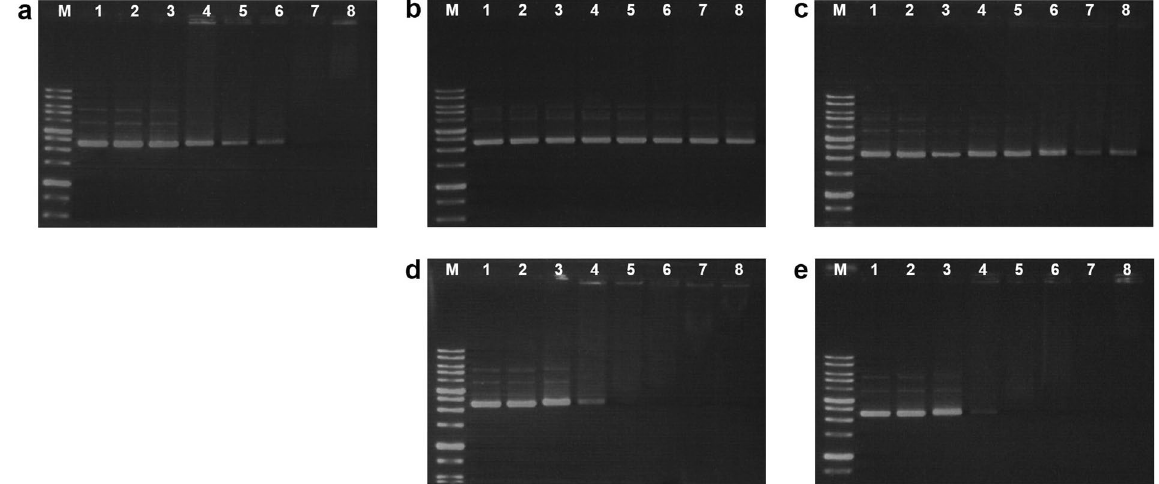
Figure 7. DNA binding assay. Peptide-DNA binding was assayed by evaluating the peptide-induced inhibition of plasmid DNA migration. ( a ) Buforin 2, ( b ) Hp1404, ( c ) Hp1404-T1c, ( d ) Hp1404-T1d, or ( e ) Hp1404-T1e were incubated with 260 ng pRSETB at 37 °C for 10 min, followed by electrophoresis in a 1% agarose gel at 100 V. The peptide:DNA ratio in each lane was as follows: lane 1, only DNA; lane 2, 0.25:1; lane 3, 0.5:1; lane 4, 1:1; lane